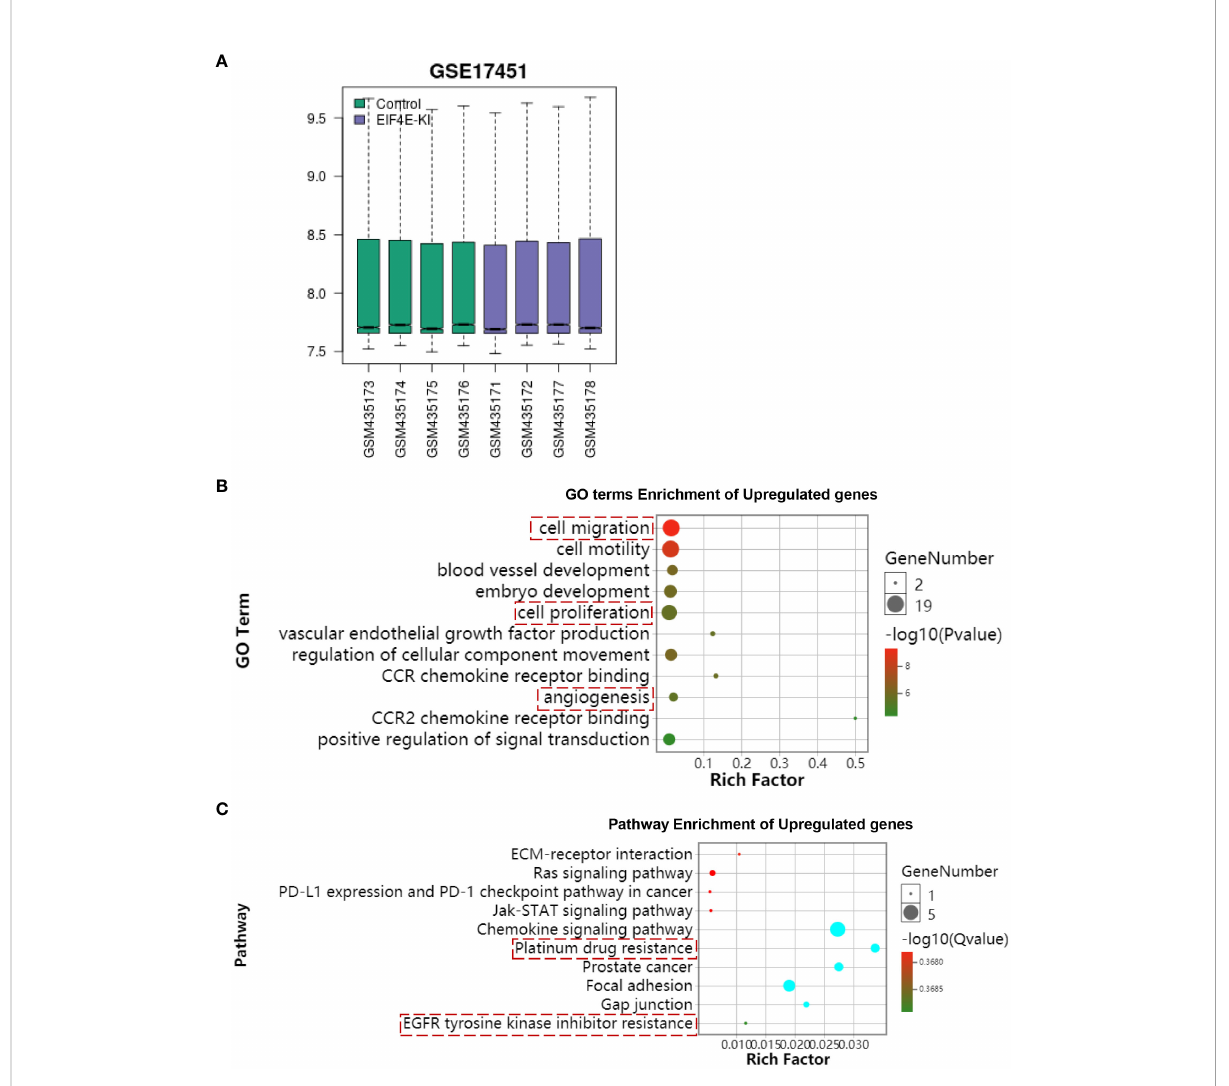
FIGURE 7 Bioinformatics analysis of overexpressed EIF4E. (A) The open source data of EIF4E-KI was downloaded through the GEO database. (B) Functional enrichment analysis of GO terms overexpressing EIF4E. (C) KEGG functional enrichment analysis of overexpressed EIF4E. The results of enrichment analysis showed that EIF4E overexpression was associated with tumor drug